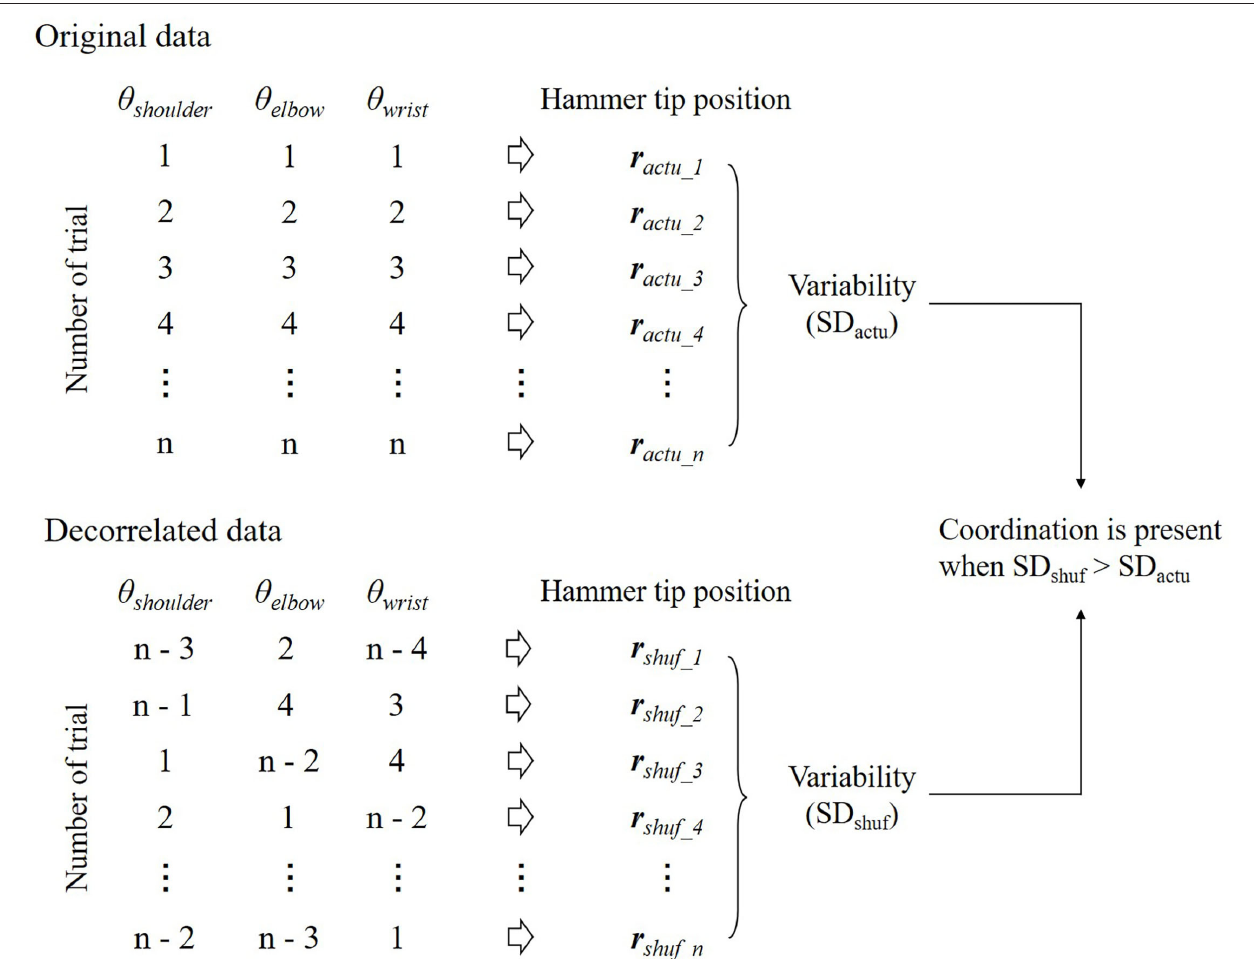
FIGURE 5 | Illustration of the covariation by randomization (CR) analysis. All variables are randomly shuffled across trials to produce decorrelated data. This procedure allows for removing any correlation between variables within a trial. The decorrelated data are substituted into a forward dynamics model to determine the performance outcome and the standard deviation (SD) after the random shuffle ( SD shuf ). If SD shuf is higher than the variability of the performance outcome for the original data ( SD actu ), the coordination between variables is present to reduce the variability of the performance